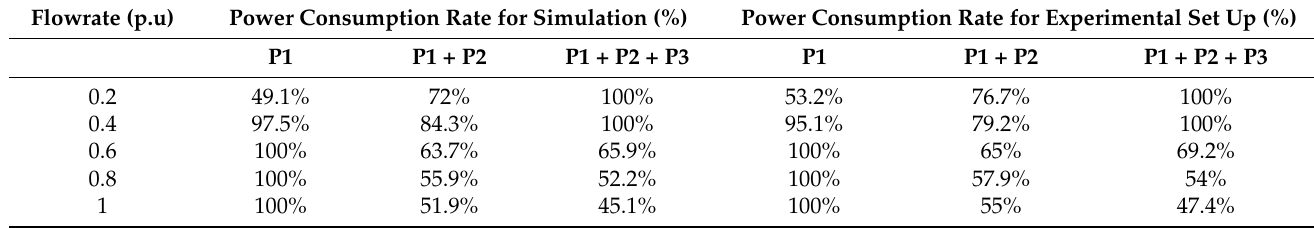
Table 5. Comparison of the energy consumption rate in percentage for modeling and experimen- tal